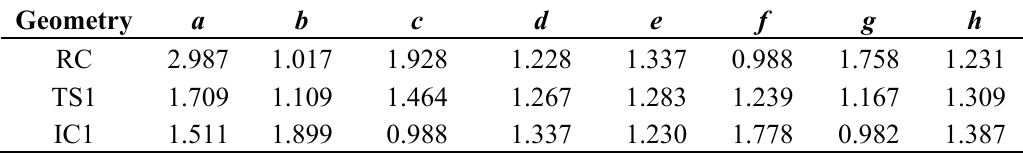
Table 1. Changes of the interatomic distances a – h (see Figure 3) (Å) in the first step.